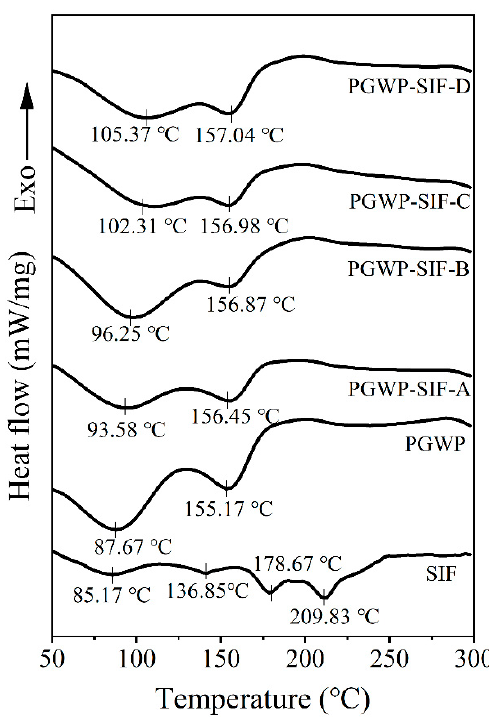
Figure 7. The di ff erential scanning calorimeter (DSC) curves of SIF, PGWP, and PGWP-SIF. Foods 2020 , 9 , x FOR PEER REVIEW 11 of 15 Figure 7. The differential scanning calorimeter (DSC) curves of SIF, PGWP, and PGWP-SIF.